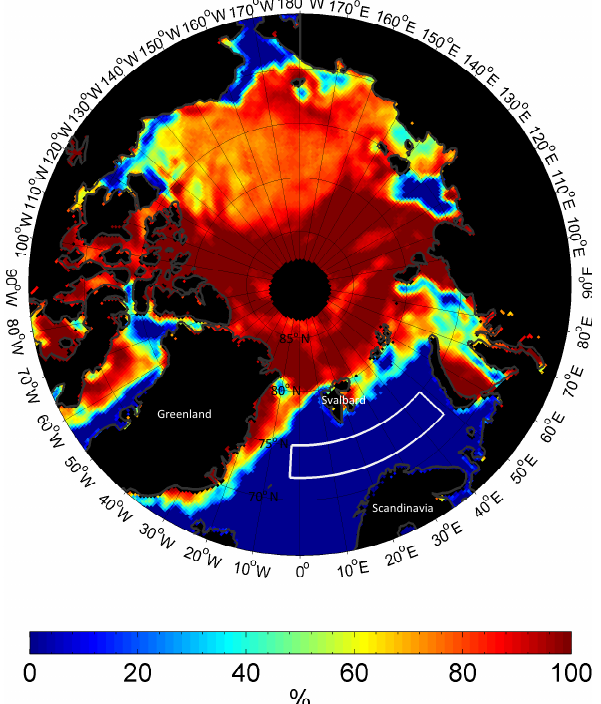
Figure 2. The region of interest for this study (white box; 72 to 75 ◦ N, − 3 to 48 ◦ E) plotted onto a map of sea-ice areal coverage (%) for 13 June 2007, which was the start of the studied period. Sea ice generally was diminishing with time throughout the